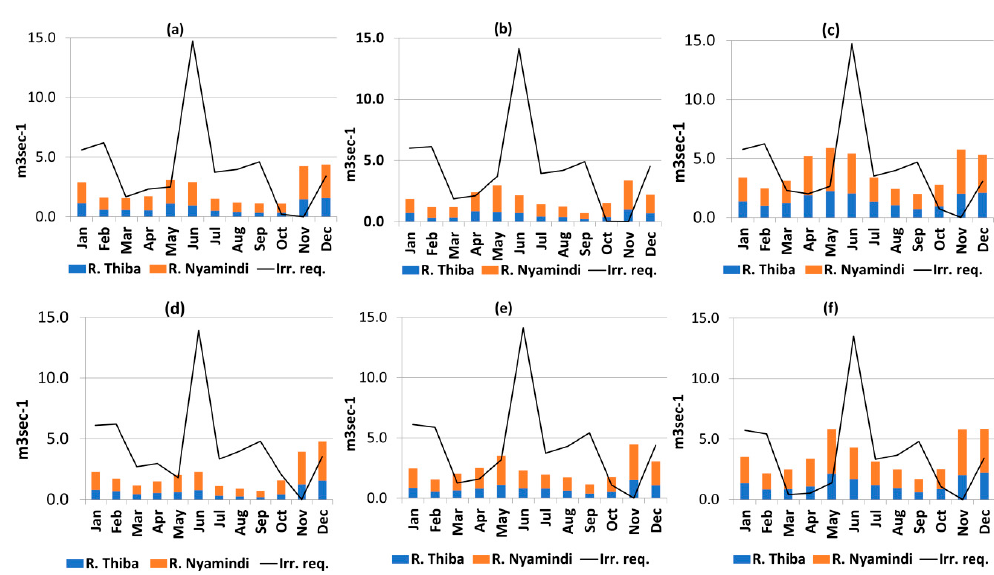
Figure 8. RCP 2.6 Comparison of total available flow and irrigation water requirements during